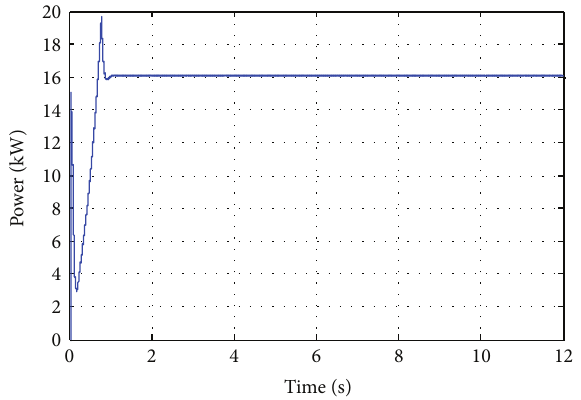
Figure 10: Evolution of the DOD in the different phases.